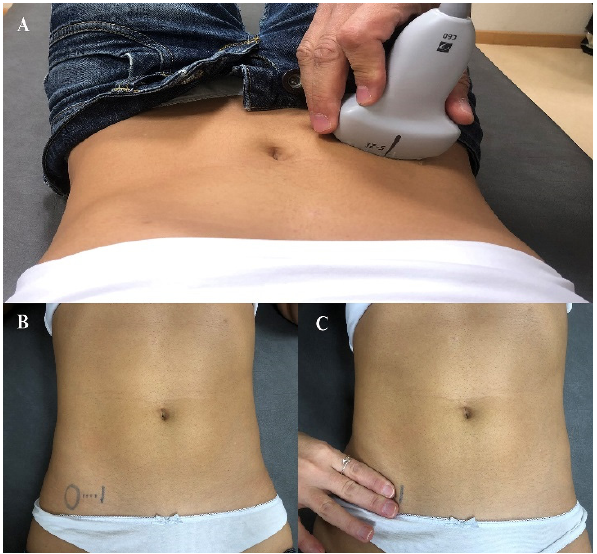
Figure 1. Ultrasound probe placed transversely just above the iliac crest in the midaxillary line ( A ); Manual palpation of the transversus abdominis by placing the index and middle fingers just 2 cm ( B ); medial to the anterior superior iliac spine ( C ).